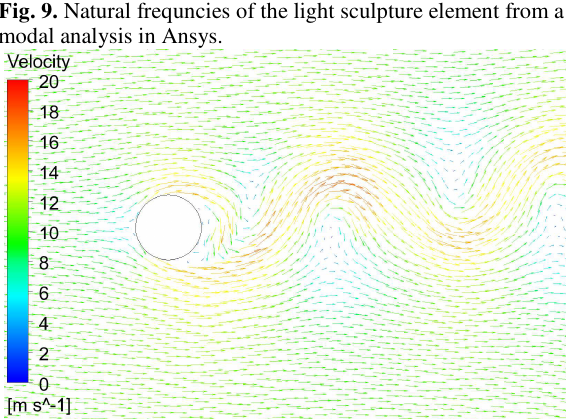
Fig. 10. Vortex shedding behind a cylinder, simple 2D analysis of the glass element